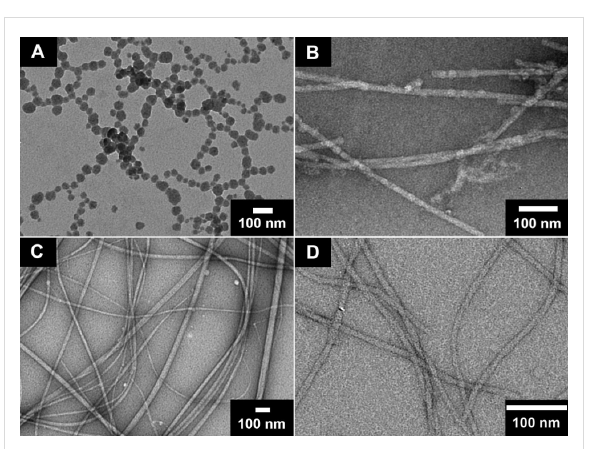
Figure 4: TEM images of the nanofibers that act as the matrices of gel I (A), gel II (B), gel III (C) and gel IV